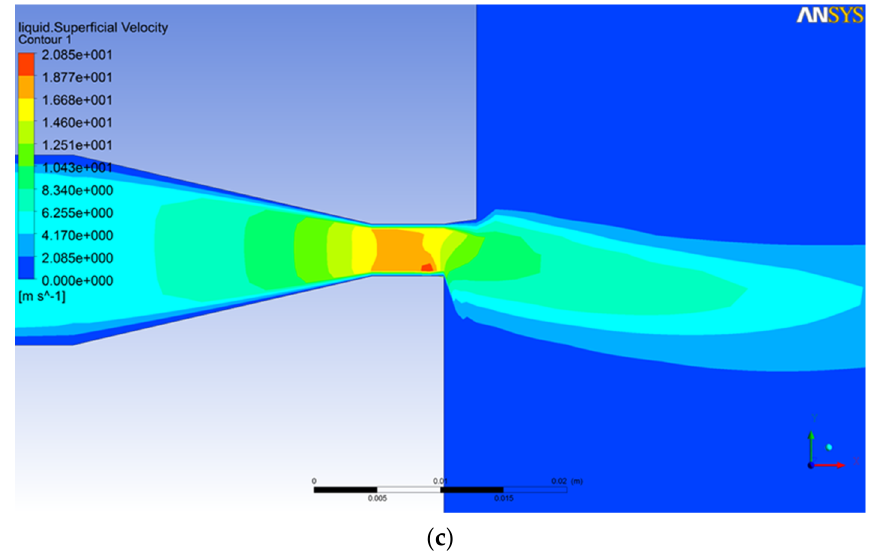
Figure 5. Velocity contours for different values of the oblique-cut: ( a ) 20°; ( b ) 40°; ( c ) 60°.